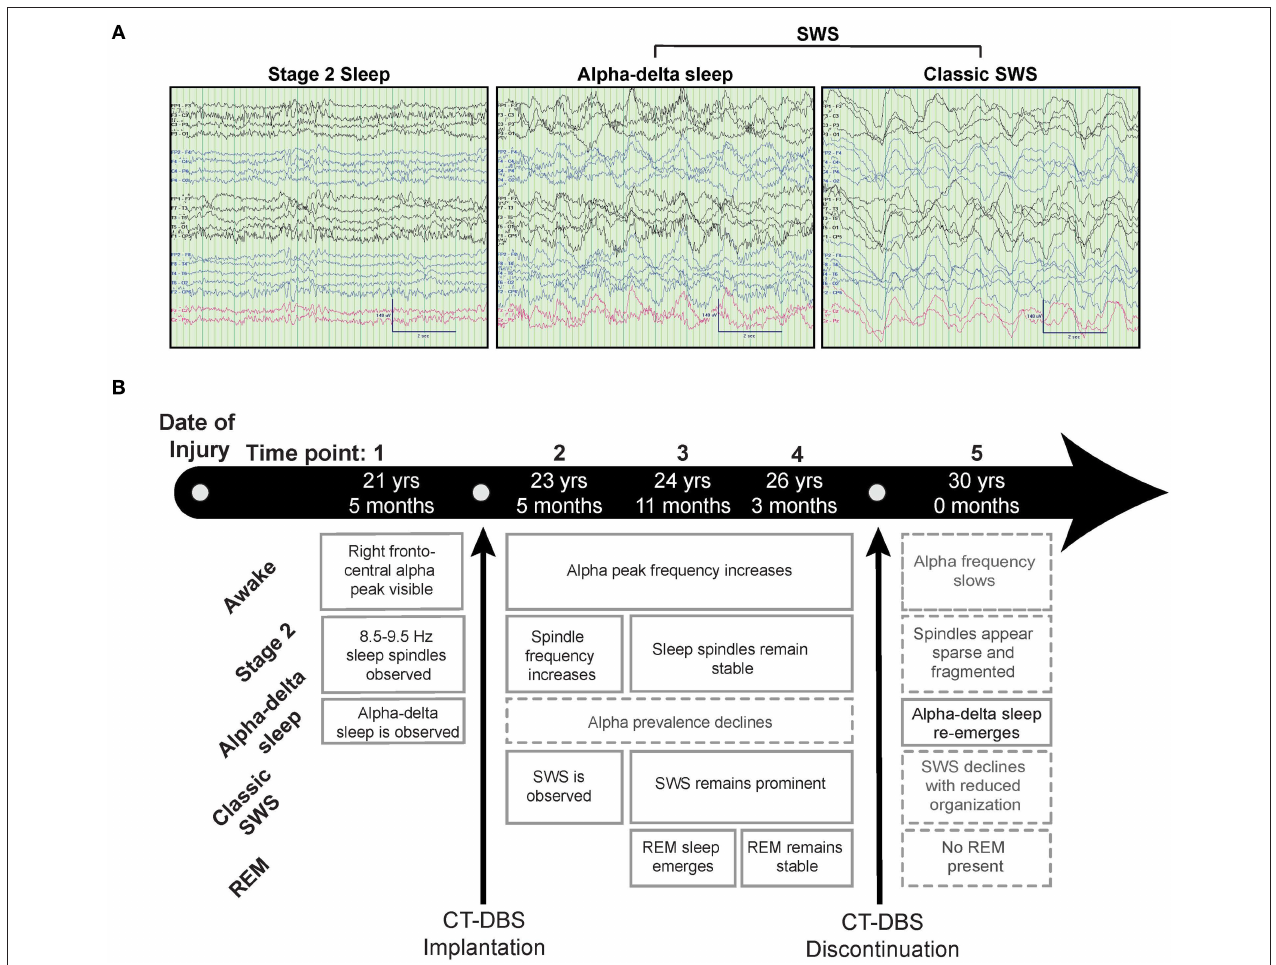
FIGURE 1 | Representative EEG and summary timeline. (A) Representative segments of patient subject EEG tracings during non-REM sleep show the presence of stage two (left) and SWS (middle, right) epochs. A mixed frequency signature consistent with alpha-delta sleep was also observed (middle), classified here as a subset of SWS for consistency with combined “SWS-like” states reported in Adams et al. ( 15). (B) The patient subject was studied at five time points over the course of 8.5 years, consisting of one time point before, three during, and one after CT-DBS treatment. Qualitative summaries of individual EEG states are shown for each time